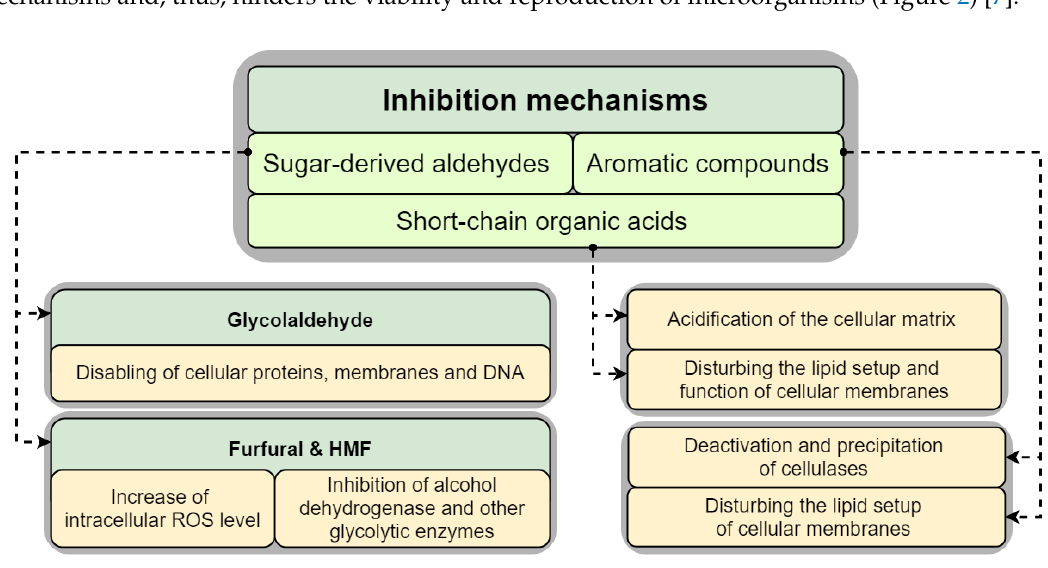
Figure 2. Inhibition mechanisms of lignocellulosic inhibitors.